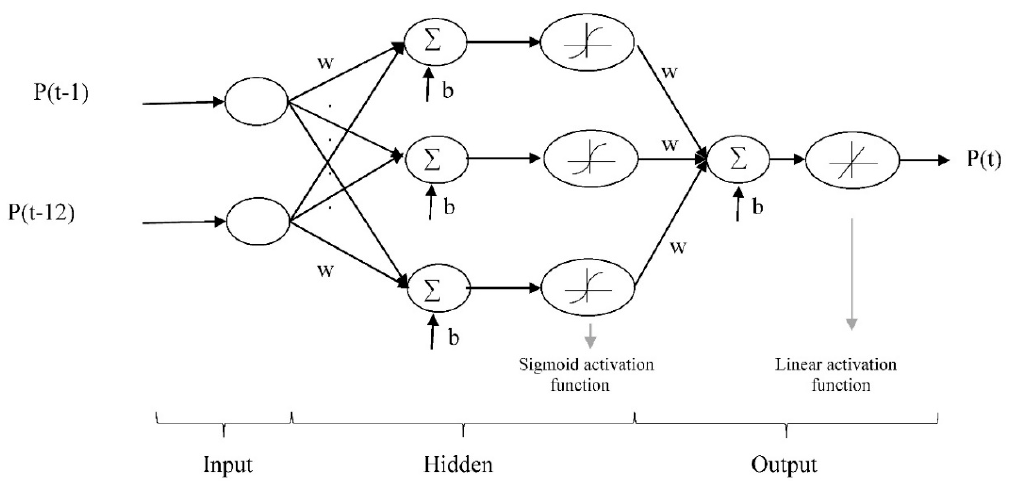
Figure 5. Structure of a three-layer feed forward neural network (FFNN).